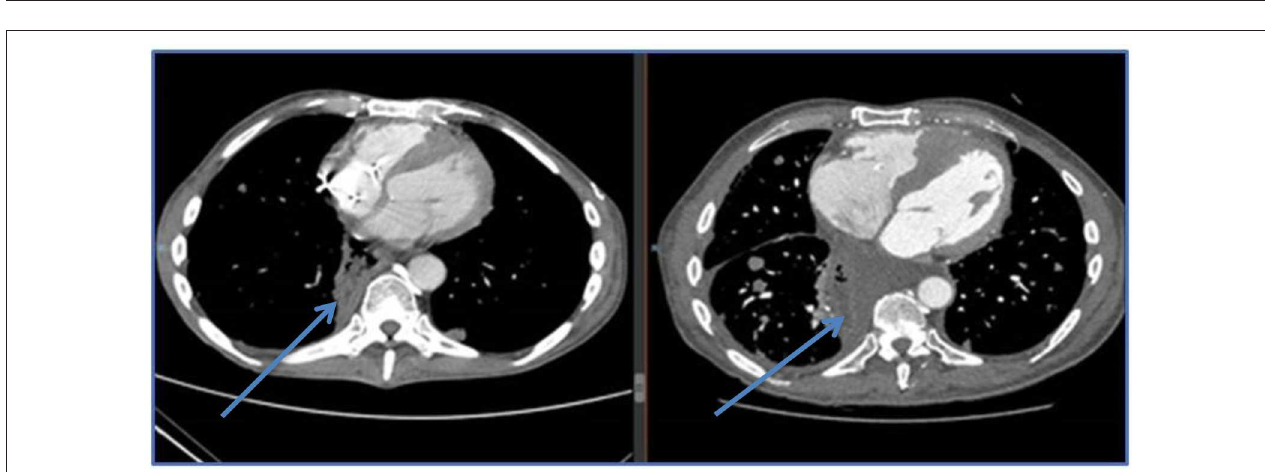
FIGURE 5 | CT images of esophageal sarcoma metastatic with cardiac infiltration and cardiac failure, right image is on exogenous L-T4, left image is post L-T4 discontinuation and oral cyclophosphamide. Patient improved clinically and was discharged from intensive care.